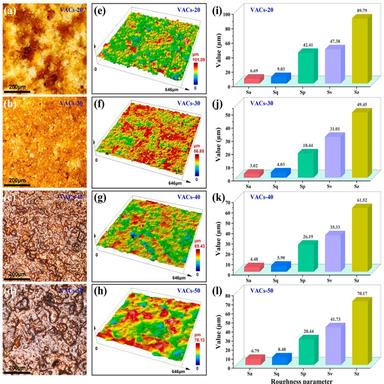
Surface CLSM image of VACs specimens with different WTPS additions: (a-d) Color laser micrograph; (e-h) 3D topography; (i-l) Surface roughness histogram.